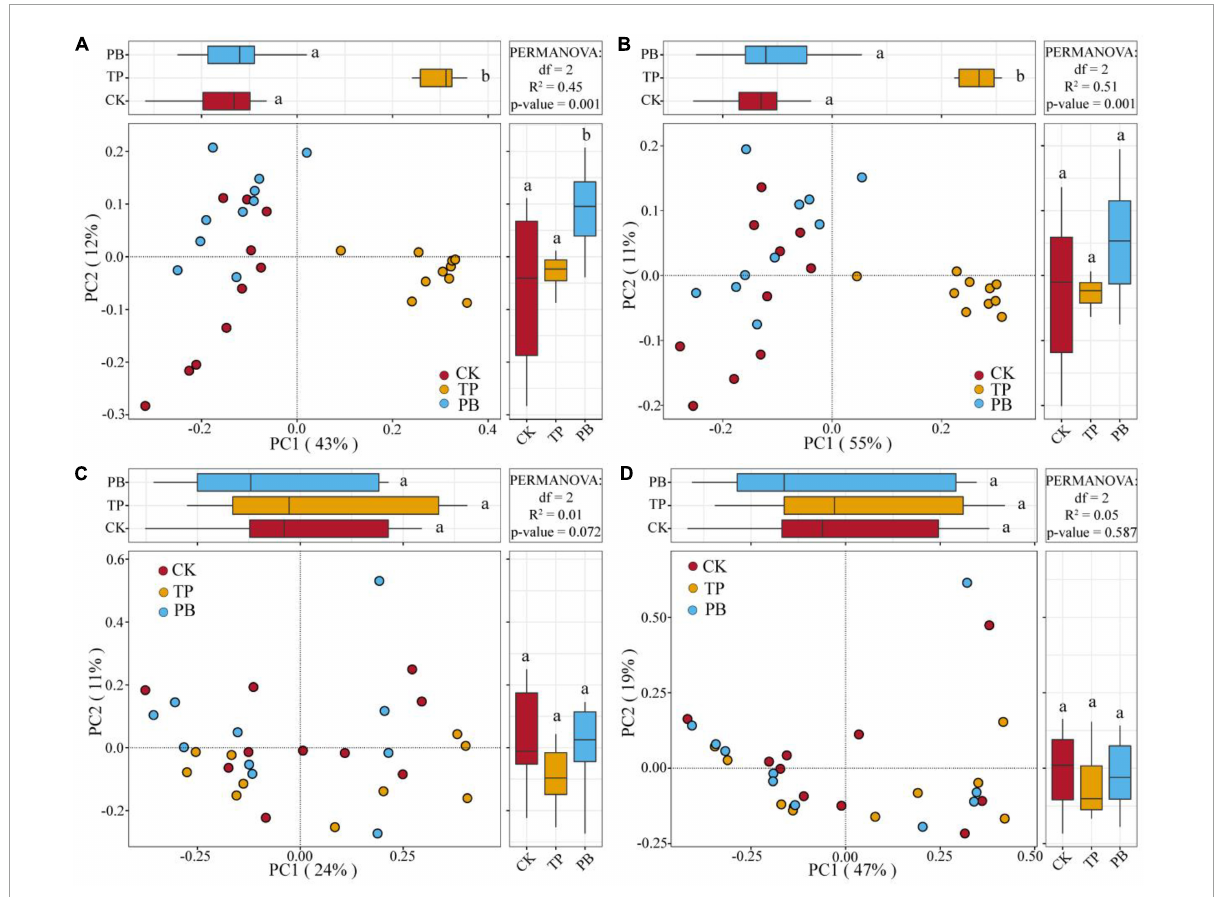
FIGURE3 Principal coordinate analysis (PCoA) of the abundant and rare bacterial and fungal communities using Bray-Curtis distances. Different letters indicate the distribution of different treatments of samples along the PC1 and PC2 axes at p < 0.05. Abundant bacteria (A) , Rare bacteria (B) , Abundant fungi (C) , and rare fungi (D)